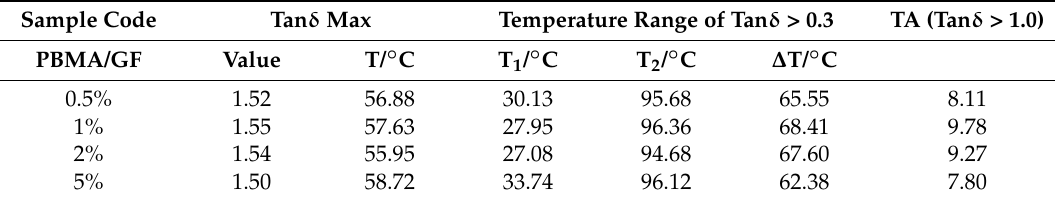
Table 4. The damping properties of PBMA/GF.